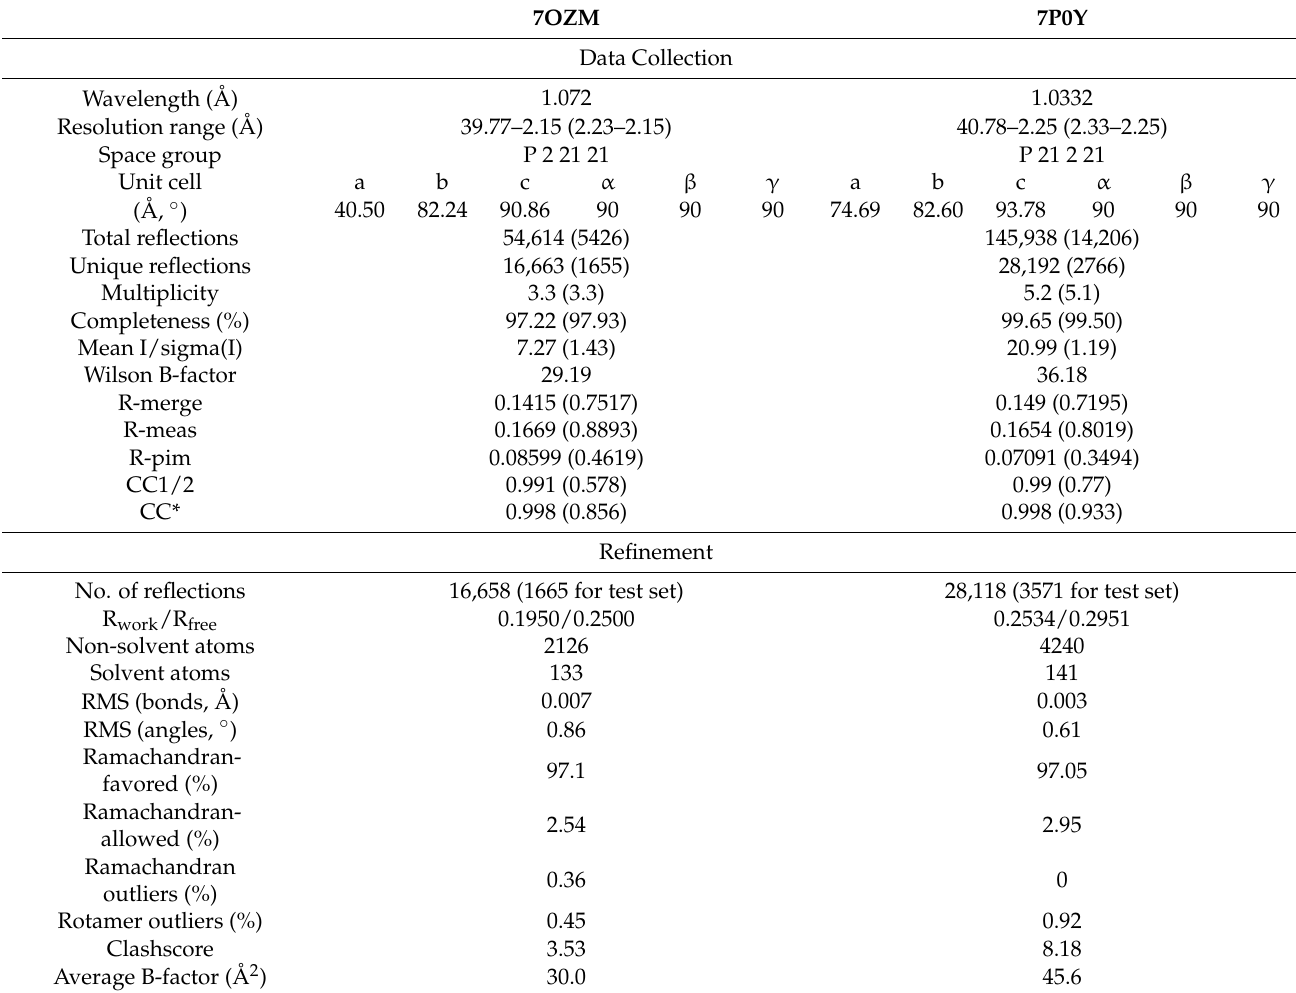
Table 1. Data collection and refinement